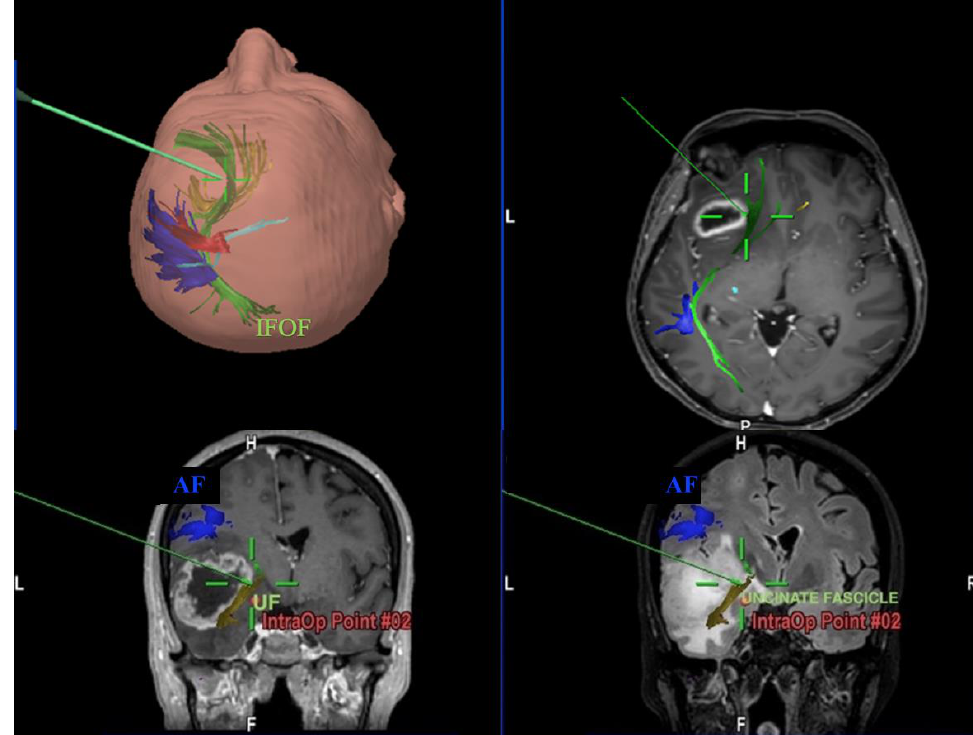
Figure 4. Intraoperative screenshots with navigated tractography of left high-grade gliomas showing the pointer of neuronavigation system that encounters IFOF (above) and UF (below).